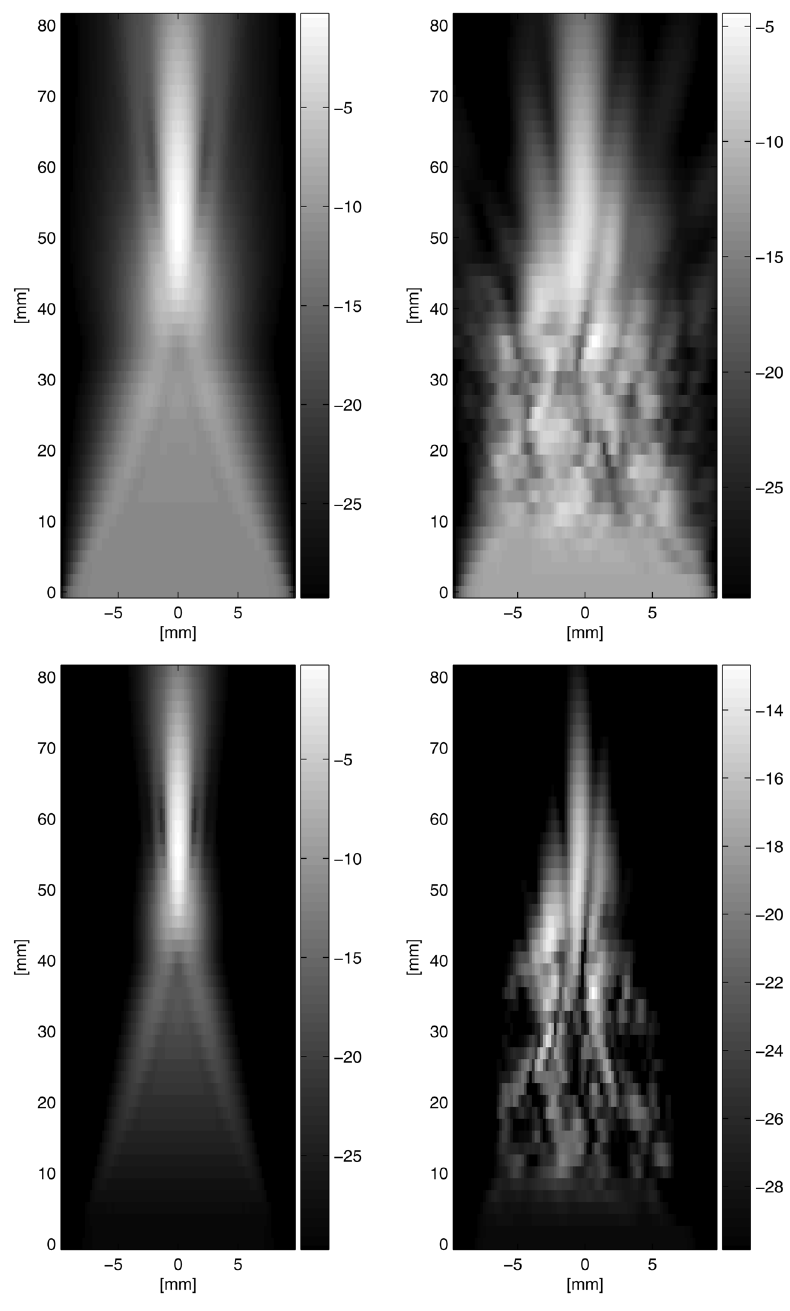
Figure 9. Acoustic energy distribution for when transmitting a 0.5 MPa and 3 MHz pulse from a 2 (cid:8) 2 cm square transducer focused at a depth of 6 cm. Top left: total energy through homogeneous muscle-like tissue. Top right: total energy through heterogeneous tissue structure resembling female breast. Bottom left: nonlinearly generated energy in a band around 6 MHz through homogeneous tissue. Bottom right: nonlinearly generated energy in a band around 6 MHz through heterogeneous